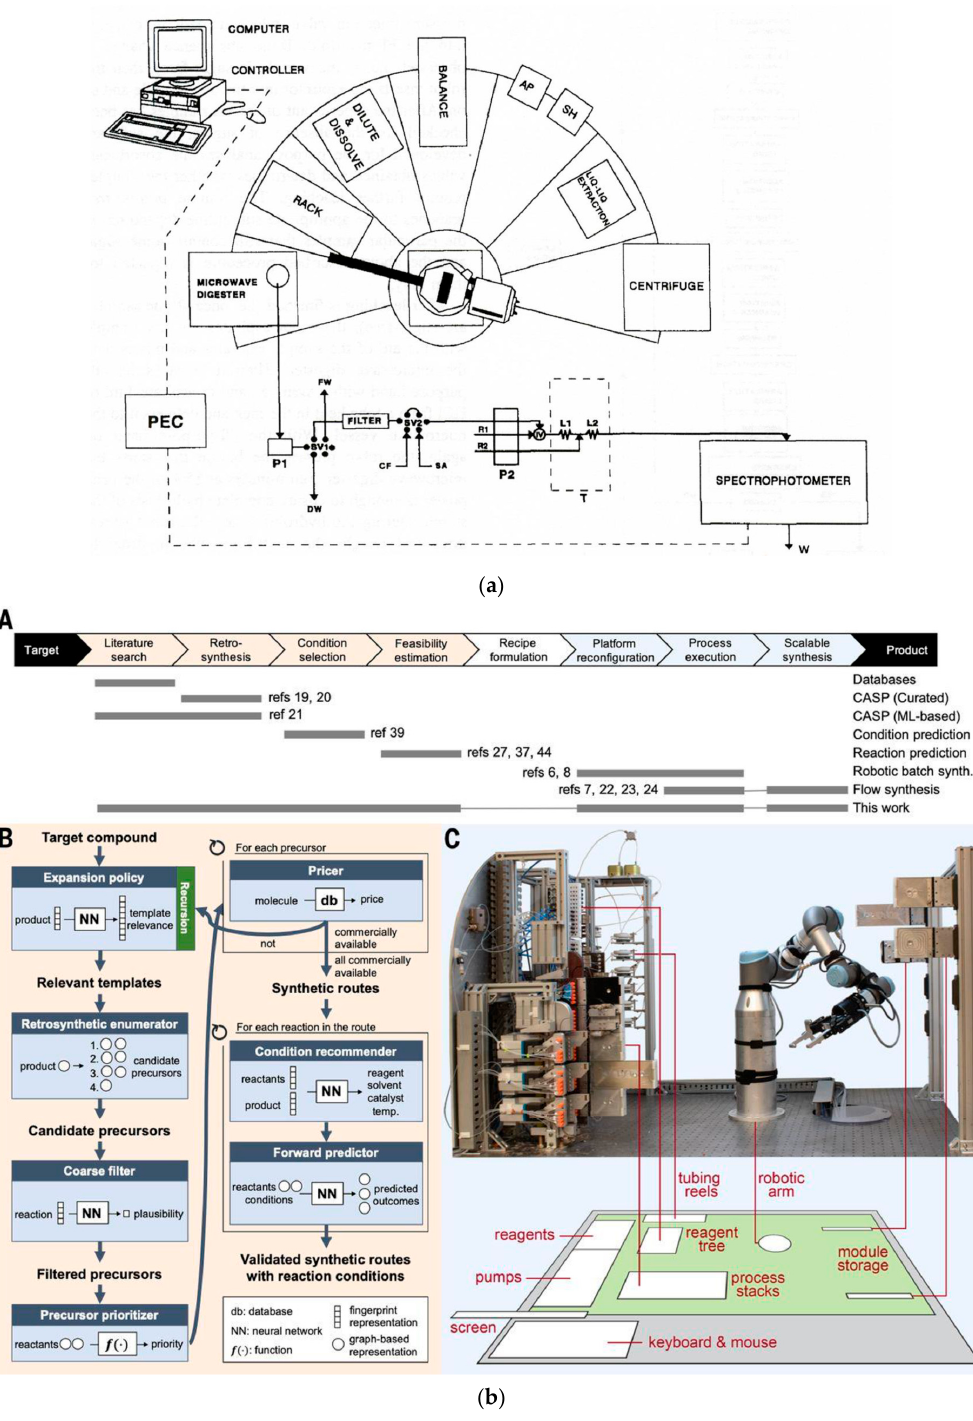
Figure 7. Examples of robotic systems developed for flow-injection analysis ( a ) [326] and flow synthesis ( b ) [52]: ( a ) FIA system developed for colorimetric determination of starch in food based on the determination of sugars using the neocuproine method; PEC—power and event controller; Ap—all-purpose hand; SH—syringe hand; P—peristaltic pump; FW—filter waste; DW—digester waste; CF—clean-up filter solution; SA—solution for assaying sugars; SV—switching valve;